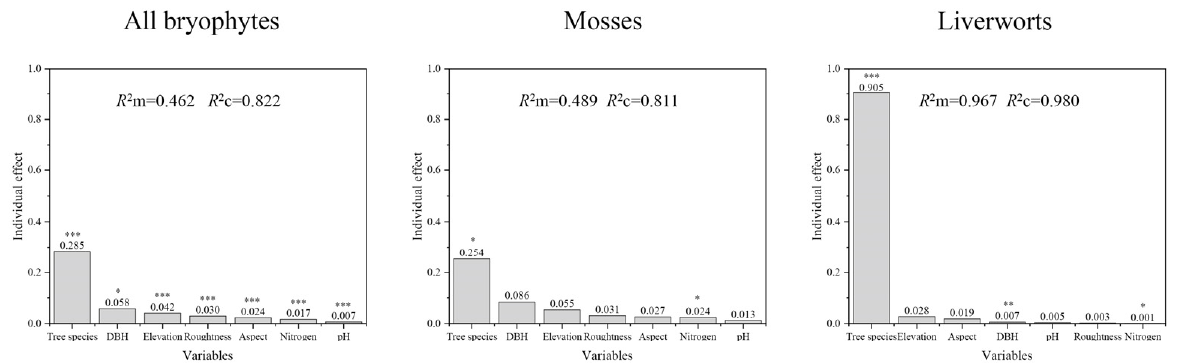
Figure 3. Summary of linear mixed effects model analyzing the effects of environmental factors on the diversity of all bryophytes, mosses, and liverworts, using elevation, aspect, tree species, nitro- gen, pH, DBH, and bark roughness grade as fixed effects. Tree species were taken as a random factor. R 2 m, R squared of fixed effect; R 2 c, total R squared for fixed effects and random effects. pH,